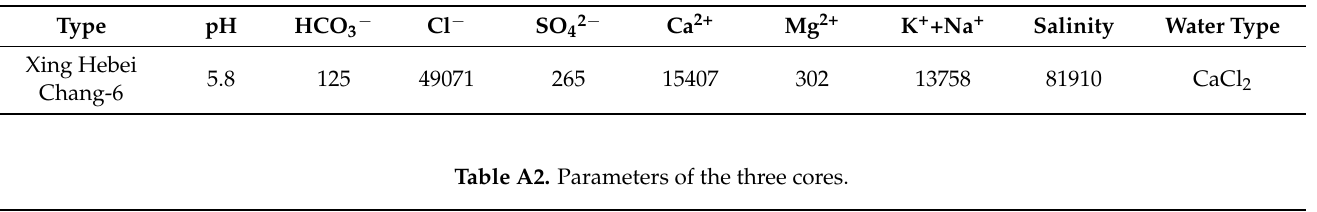
Figure A5. Zeta potential of C 8 -OMImBF 4 at different concentrations. Table A1. Composition and salinity of XingHebeiChang-6 simulate formation water.